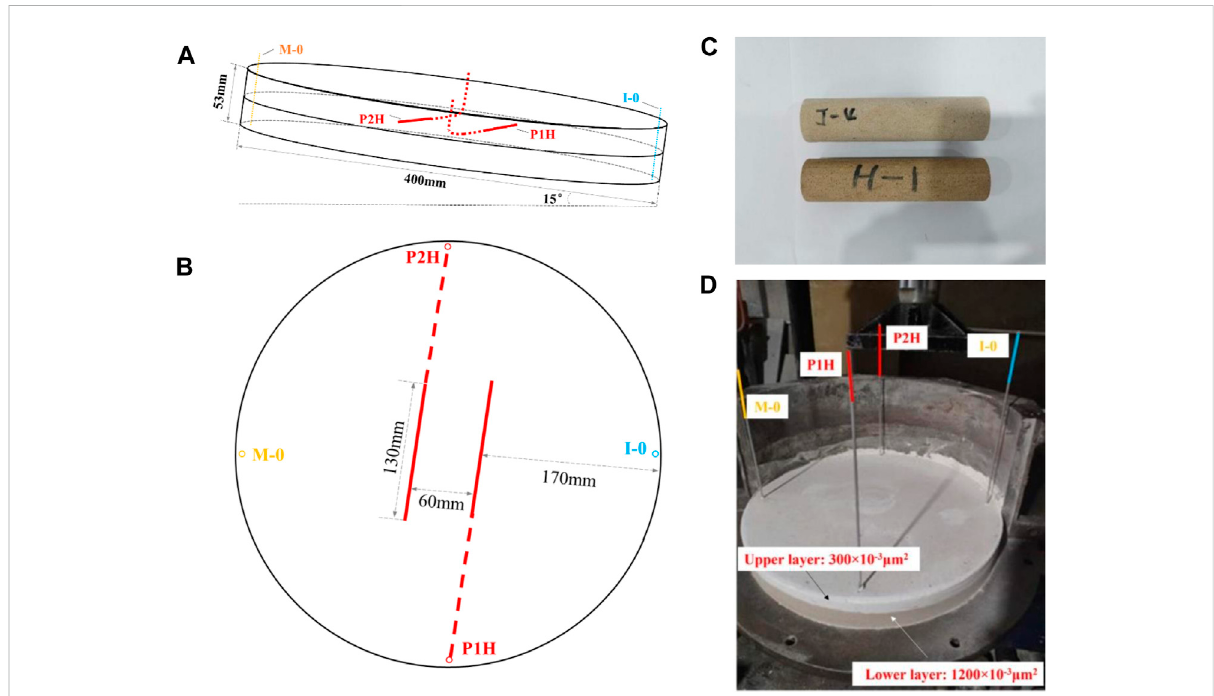
FIGURE 3 3D physical model used for the well-to-well interplay of CO2 huff-n-puff. (A) Side view and (B) top view of the designed model. (C) Picture of the 1D core. (D) Picture of the 3D core.